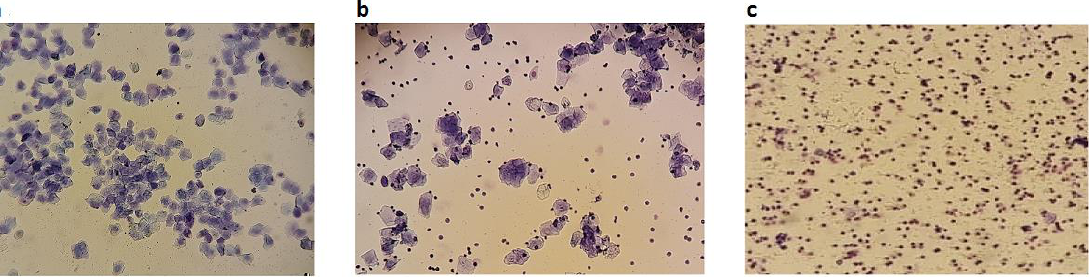
Figure 2: Determining the estrous cycle stages by vaginal smear/cytology: a ) Estrus stage: non- nucleated surface cells. b ) Metestrus stage: with non-nucleated surface cells, leukocytes, and epithe- lial cells. c ) Diestrus stage: identified by predominant presence of leukocytes (Magnification,